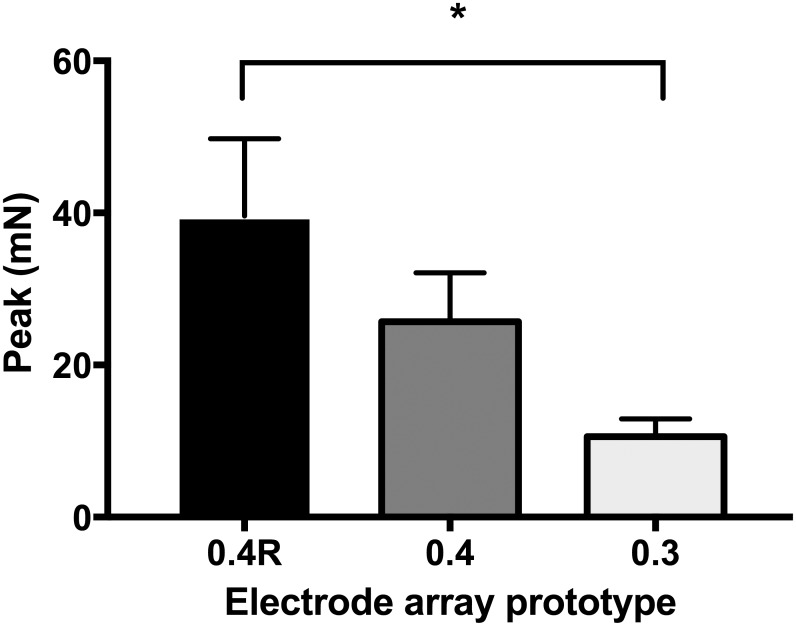
Maximal peak force measured during insertion of the three electrode array types.Electrode array geometry influences the maximal peak of the insertion force. Values are means± SEM. One-way Anova, *p<0.05.